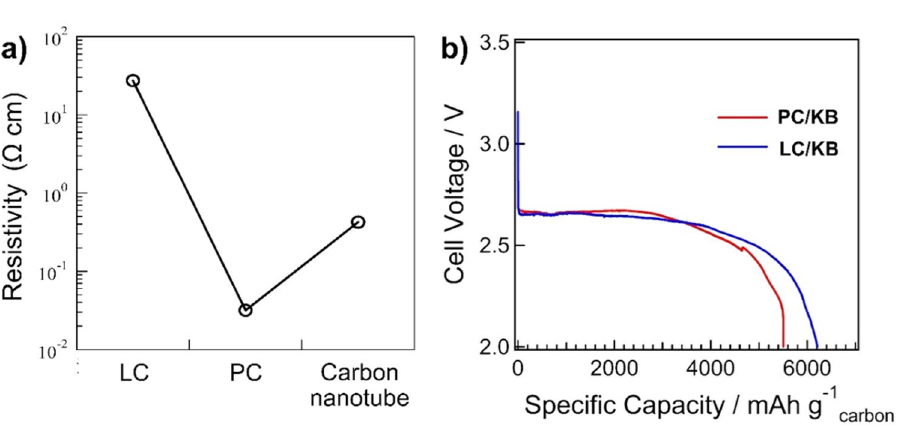
Figure 6. ( a ) Electronic conductivity and ( b ) initial full discharge curves of battery cells with PC/KB and LC/ KB cathodes at current density 100 mA g –1 and cut-off voltage of 2